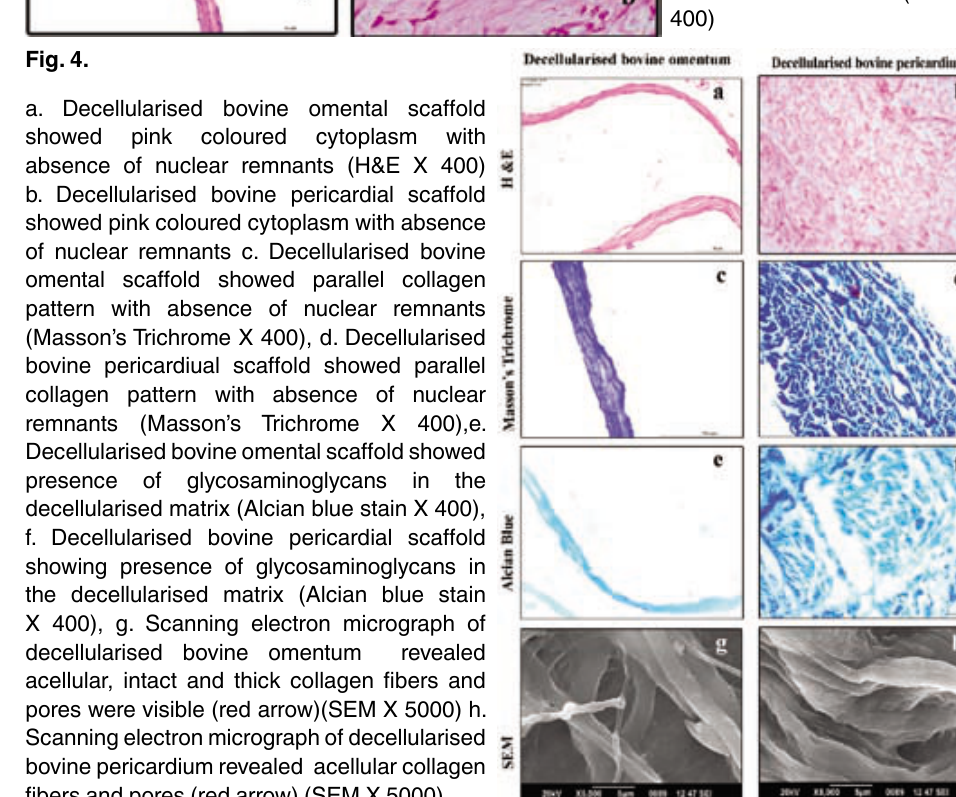
Fig. 3. a. Non decellularised bovine omentum showing nucleus in the matrix (H&E X 400) b. Non decellularised bovine pericardium showing nucleus in the matrix (H&E X 400)